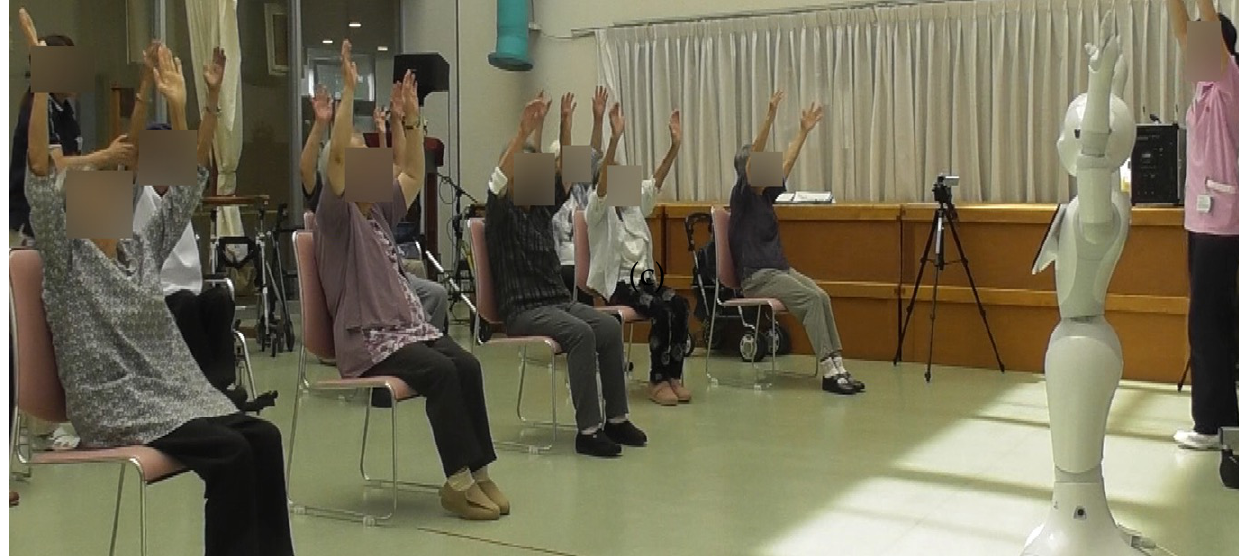
Figure 4. Scene of range-of-motion of the shoulder exercises instructed by Pepper